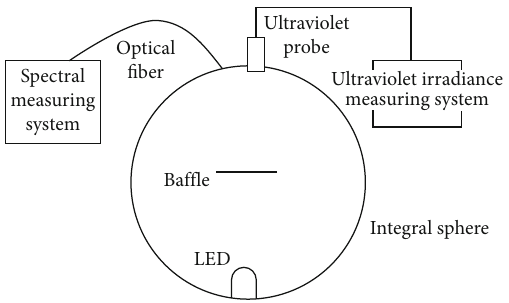
Figure 2: Test principle of LED light color electrical parameter comprehensive